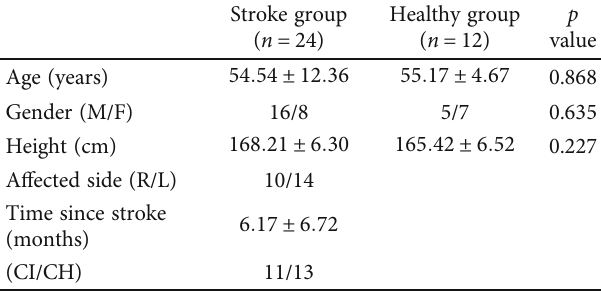
Table 1: Demographic and clinical characteristics of the